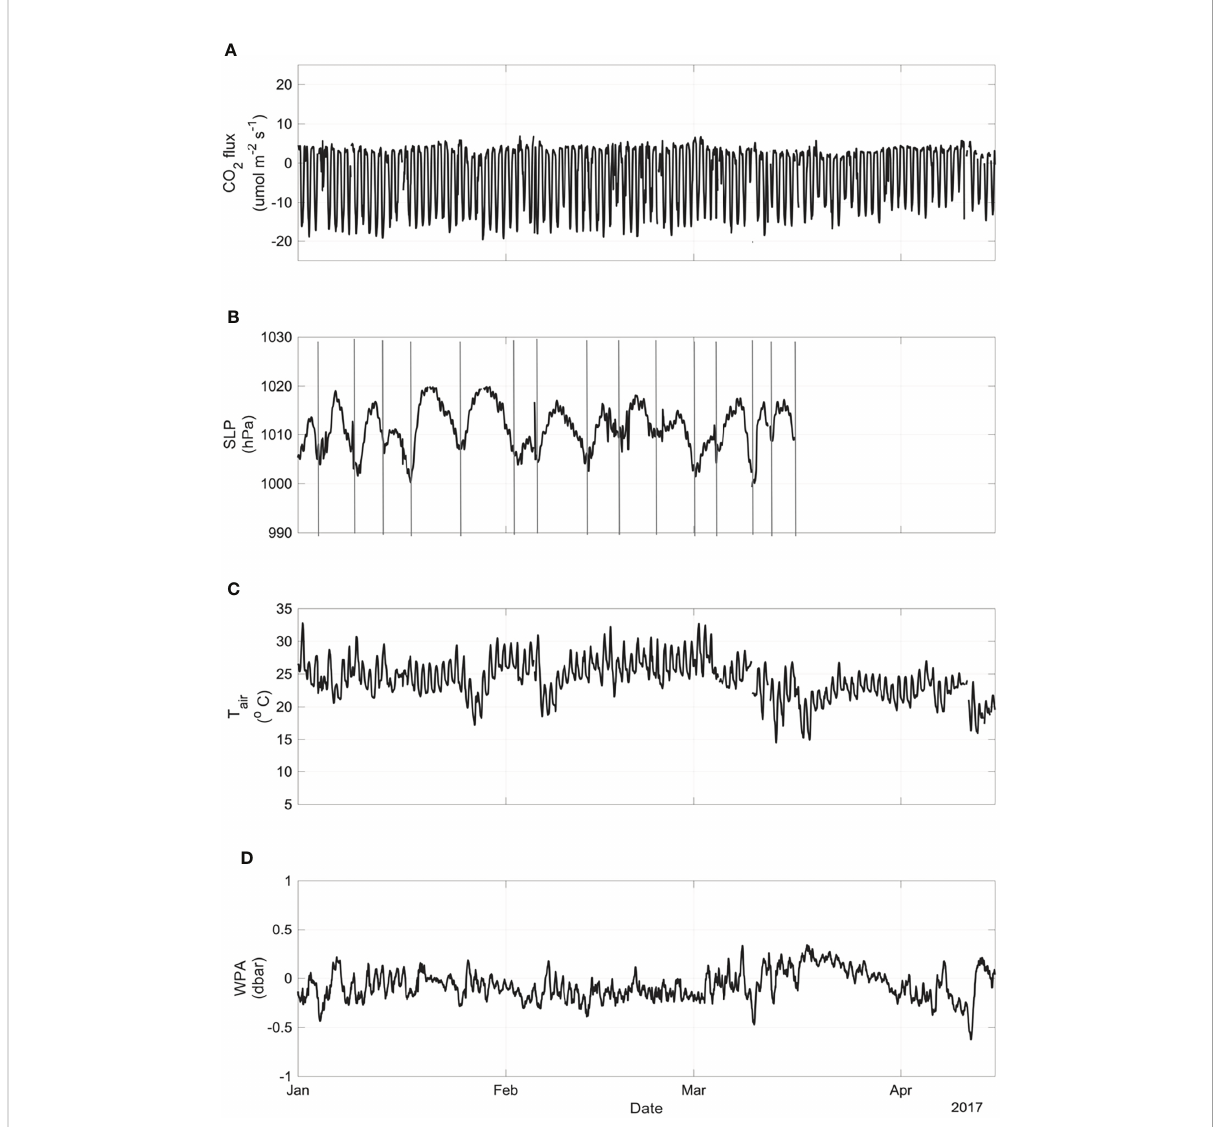
DC FIGURE 3 Time series of (A) CO 2 fl uxes at the salt marsh-atmosphere interface; (B) sea level pressure (SLP); (C) air temperature (T air ); (D) water pressure anomaly (WPA) for the period spanning from July up to November 2016. The vertical gray lines in (A) indicate the pressure troughs associated with the passage of atmospheric cold fronts in the study area.The mean values of net CO 2 fl ux are negative and almost the same for both periods of this study (-3.23 to -3.20 m mol m -2 s -1 ) (Table 1). Mean value of night fl uxes (a proxy of community respiration) is about 4.6 times higher in summer-fall than in winter-spring (Table 1). Daytime mean fl uxes, related to the community photosynthetic activity, varied between (-6.71 to -7.95 m mol m -2 s -1 ) between the two periods analyzed. The mean value of nighttime fl uxes, on the other hand varied between 0.67 (winter-spring) to 2.95 m mol m -2 s -1 (summer-fall). Variability in mean values of CO 2 fl uxes is higher during daytime when compared to the nighttime measurements, for both periods (Table 1), following the high variability in the incoming shortwave radiation, a variable dependent on the cloudiness (Supplementary Figures 6C, Using Table 1 data for the net CO 2 seasonal fl uxes, the annual Extrapolating this value for the total extension of the Patos Lagoon average of the CO 2 taken up by the salt marsh can be estimated as salt marshes (72 km 2 ; Nogueira and Costa, 2003) gives us an -3.215 m mol CO 2 m -2 s -1 or -3.215 x 10 -6 mol CO 2 m -2 s -1 . annual carbon fi xation rate for the entire area covered by the Patos Lagoon marshes close to -87.6 x 10 9 g C yr -1 (-87.6 Mg C yr -1 ). Considering that the mass of carbon in a mol of CO 2 is 12 g and applying the correct transformations of units, this results in a Some of the CO 2 fl ux cycles seen in Figures 2A, 3A follow the theoretical fi xation tax of carbon close to -1217 g C m -2 yr -1 . cycles presented by the environmental variables studied here.